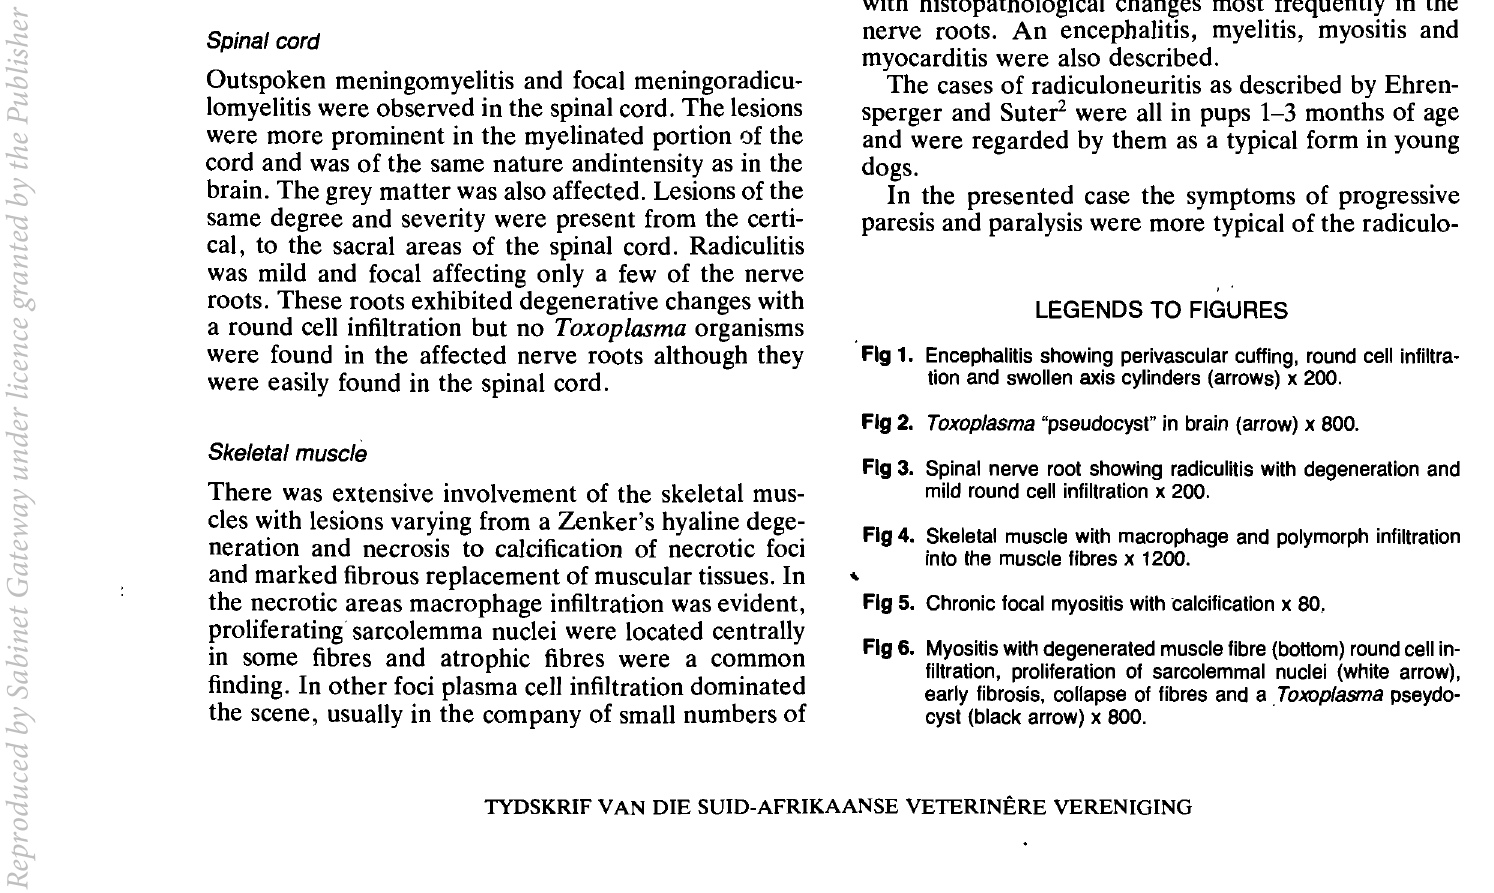
Fig 1. Encephalitis showing perivascular cuffing, round cell infiltra tion and swollen axis cylinders (arrows) x 200. Fig 2. Toxoplasma "pseudocyst" in brain (arrow) x 800. Fig 3. Spinal nerve root showing radiculitis with degeneration and mild round cell infiltration x 200. Fig 4. Skeletal muscle with macrophage and polymorph infiltration into the muscle fibres x 1200. Fig 5. Chronic focal myositis with calcification x 80. Fig 6. MyositiS with degenerated muscle fibre (bottom) round cell in filtration, proliferation of sarcolemmal nuclei (white arrow), early fibrosis, collapse of fibres and a . Toxoplasma pseydo cyst (black arrow) x 800.